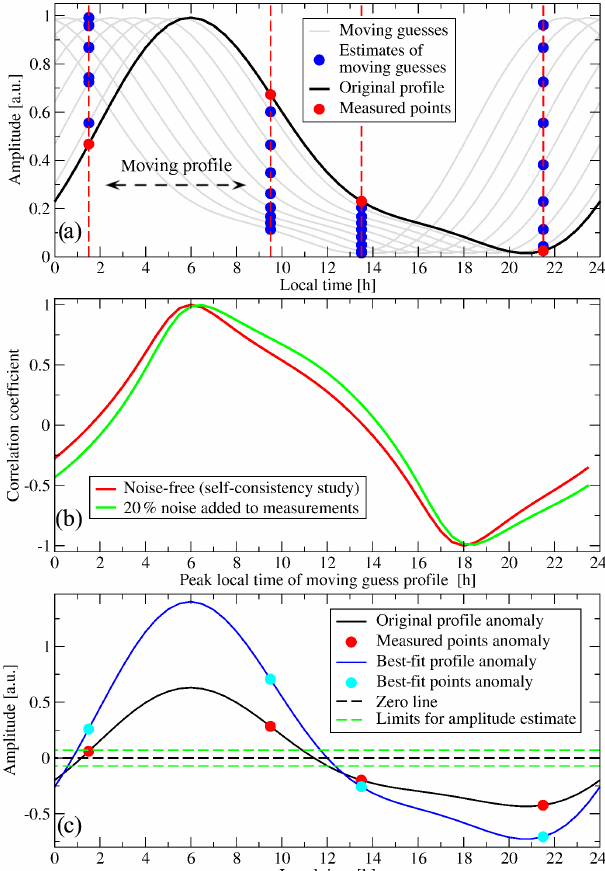
Figure 2. Illustration of the approach to estimate the diurnal vari- ation phase and amplitude from four measurements, taking advan- tage of a known form of the variation: (a) “true” profile measured at four points and moving guess profiles; (b) Pearson’s correlation co- efficient calculated for guess profiles for noise-free and noisy simu- lations; (c) determination of the amplitude with the phase